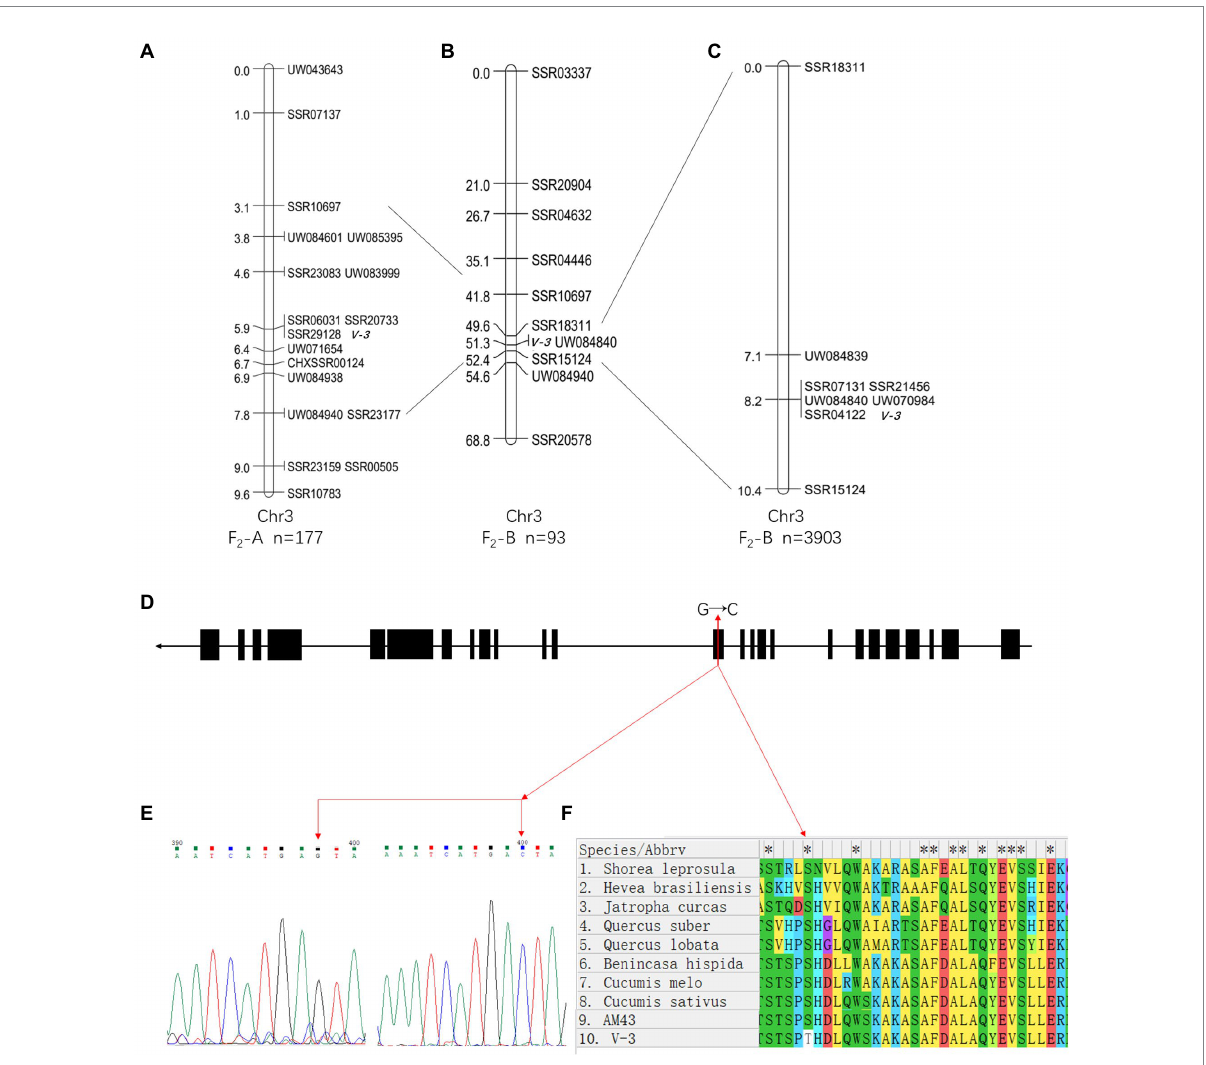
FIGURE 6 Positional cloning and sequence alignment of the v-3 gene. (A) Numbers on the chromosome left are genetic distance (cM). (B) Mapping based on 93 plants from the F 2 -B population placed the v-3 locus on chromosome 3 at a 2.8 cM region. (C) Mapping based on 3,903 plants from the F 2 -B population placed at the v-3 locus between UW084839 and SSR15124. (D) Structure of the v-3 candidate gene, which has 25 exons. The SNP (G → C) in exon 13 changes serine to threonine. (E) Sequencing peak map of the SNP sites in v-3 and the WT. (F) Protein sequence alignment of the RST1 gene in “SC311,” “ v-3 ,” “ Cucumis sativus ,” “ C. melo ,” “ Benincasa hispida ,” “ Shorea leprosula ,” “ Jatropha curcas ,” “ Hevea brasiliensis ,” “ Quercus suber ,” “ Q. lobata .” *a conservative sequence. Black boxes and black lines indicate exons and introns, respectively. SNP, single nucleotide